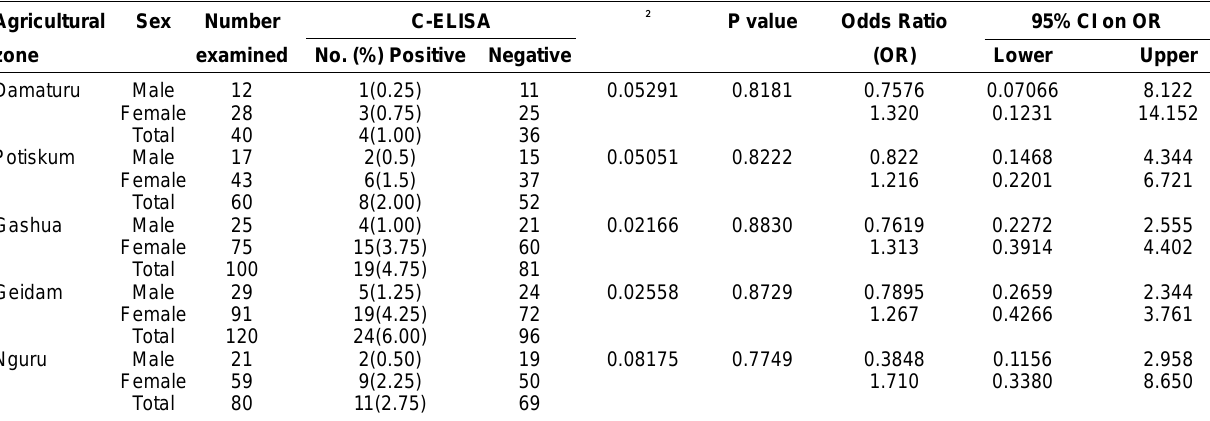
Table-3. Agricultural zone specific prevalence of Brucella antibodies in camel herds in Yobe